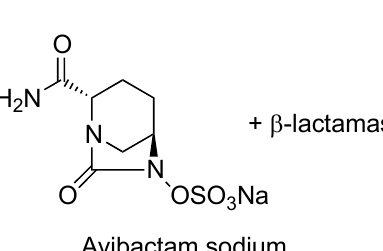
Figure 3. Mechanism of action of